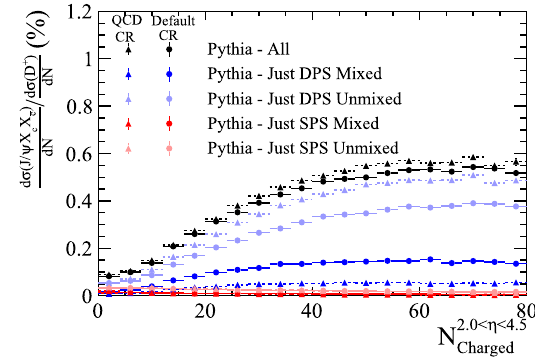
Fig. 25 Ratioofdifferentialcross-sectionofJ / ψ X c X c andD + hadrons as a function of (left) the number of parton interactions in a collision and (right) the number of charged particles within the pseudo-rapidity Fig. 26 Relative transverse distributions in J / ψ X c X ¯ c events for DPS processes in both the mixed and unmixed configurations, as generated with Pythia with the colour reconnection options specified in Table